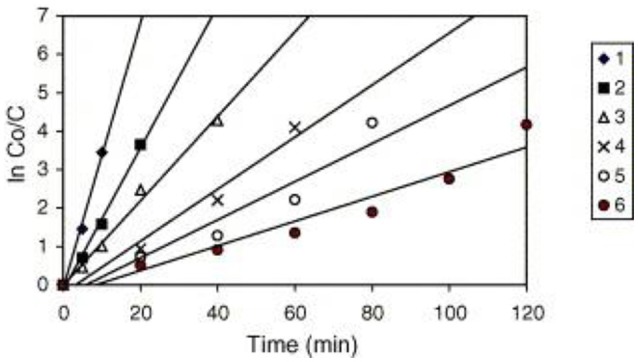
Kinetics of RY14 decolorization by UV/TiO2-P25 for different initial dye concentrations. TiO2-P25 = 4 g/l, pH 5.5 ± 0.1. [1] = 1 × 10−4 mol/l, [2] = 2 × 10−4 mol/l, [3] = 3 × 10−4 mol/l, [4] = 5 × 10−4 mol/l, [5] = 7 × 10−4 mol/l, and [6] = 9 × 10−4 mol/l ((Muruganandham and Swaminathan, 2006); Reprinted by permission).